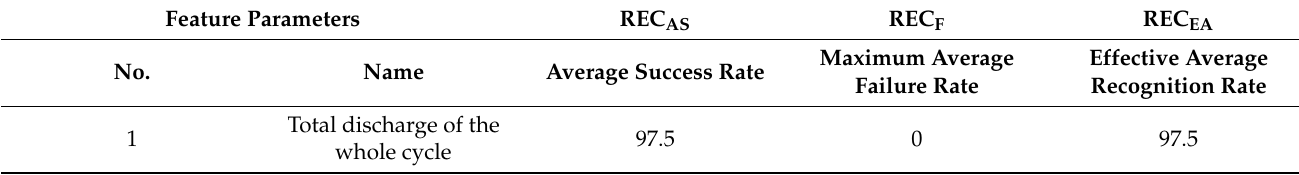
Table 10. GIS-2 better recognition rate: basic discharge parameters.